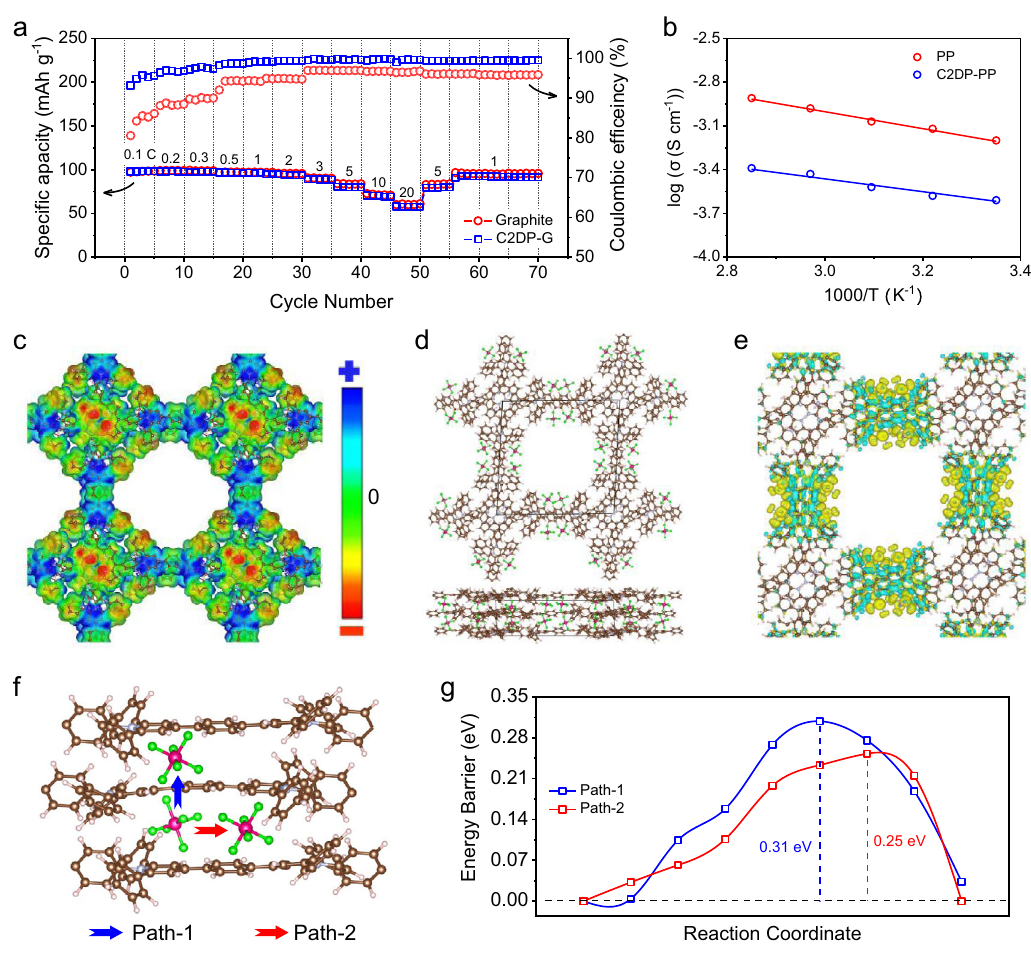
e charge density difference plots ( ρ adsorbed − ∑ ρ isolated , isosurface value=0.0002 eÅ − 3 ) of C2DP with PF 6 − as counter ions. f Schematic illustration of PF 6 − -diffusion paths and g the corresponding PF 6 − -diffusion energy